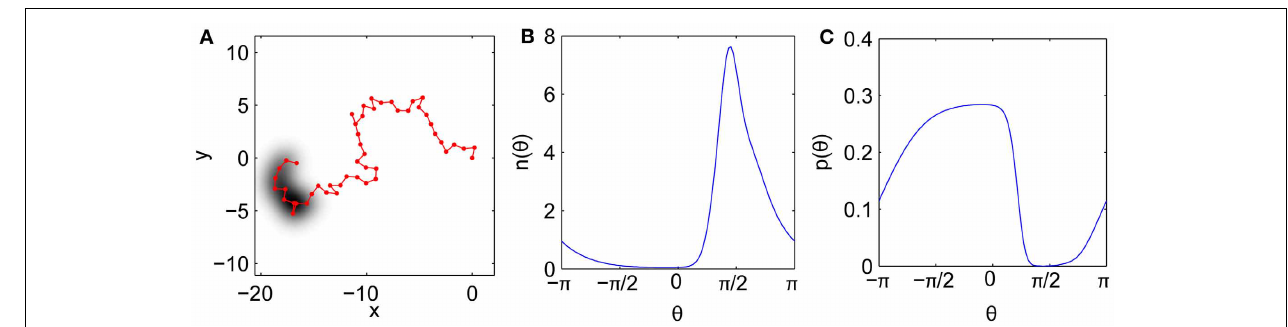
FIGURE 7 | Model mechanism. (A) Example fixational gaze trajectory with imprecise history representation shaded. (B) History angular density n ( θ ) as measured from the current point. (C) Resulting angular distribution p ( θ ) for the next step after penalizing the